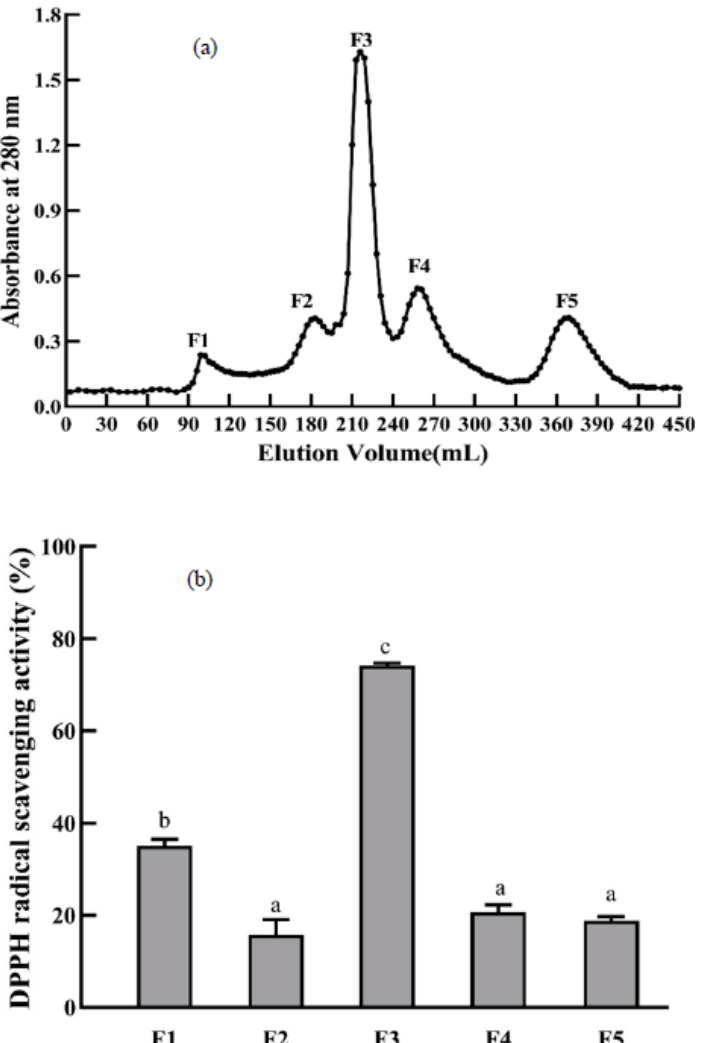
Figure 5. Elution profile of EBNH-2 on an Sephadex G-25 column ( a ); DPPH radical scavenging activities for EBNH-2 subfractions (F1–F5) at a concentration of 1 mg/mL ( b ). The data indicated as means ± SD (n = 3). The column values of a–c with the same superscript indicated an insignificant difference ( p > 0.05).